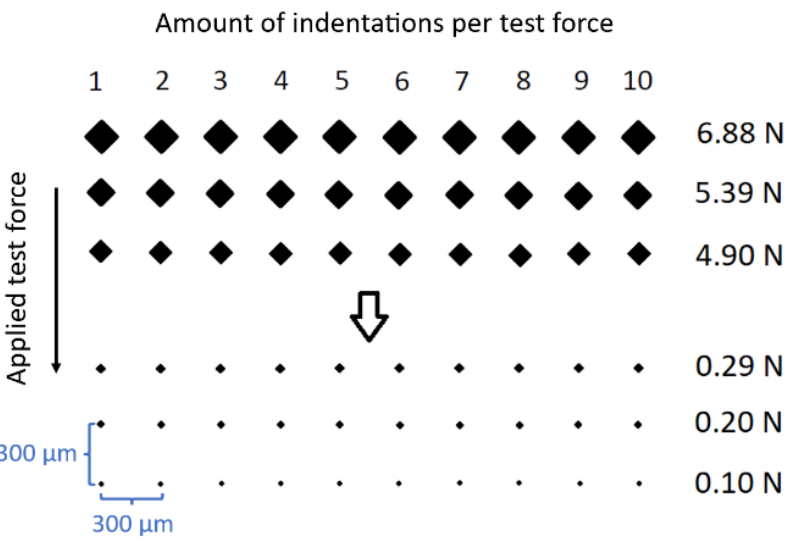
Figure 1. Micro-indentation hardness test matrix. Ten measurements with twenty different test forces were performed to analyze the coating’s microhardness. Indentations were spaced 300 micrometers apart in both X and Y directions. Ten indentations were performed for each test force.